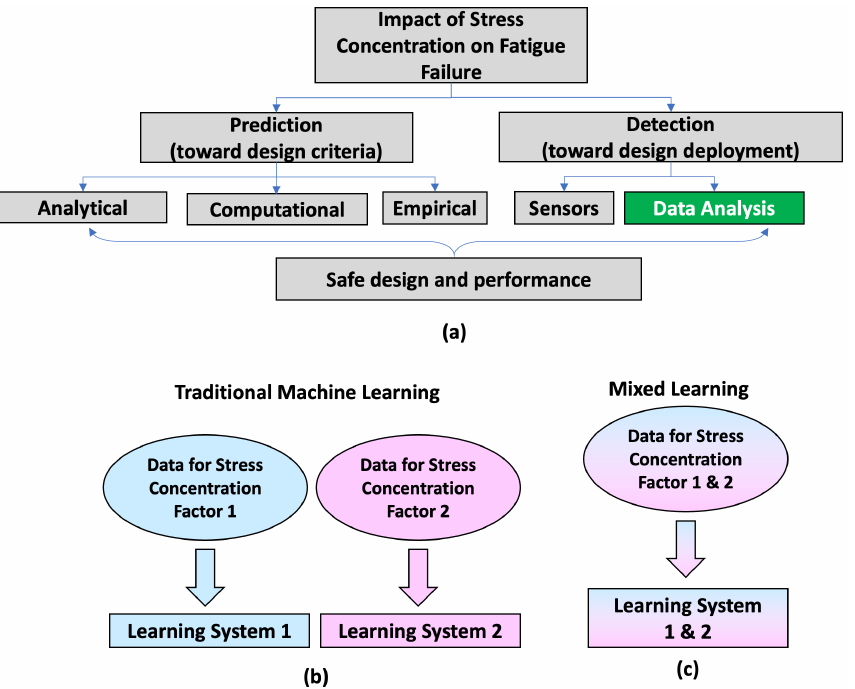
Figure 1. ( a ) A block diagram highlighting the impact of stress concentration on fatigue failure. A schematic of the ( b ) traditional machine learning and ( c ) proposed mixed learning model inspired by multilingual deep neural